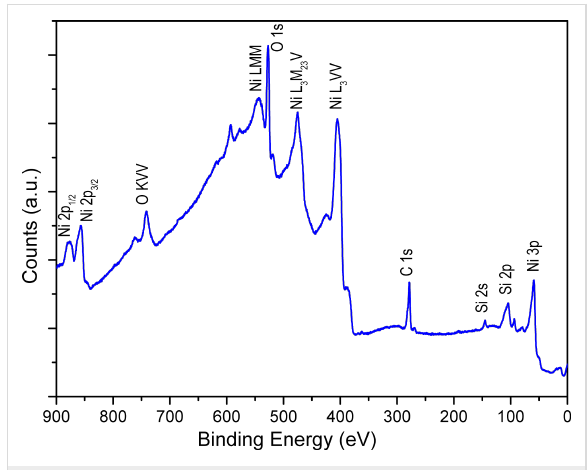
Figure 6: XPS survey spectrum of metallic